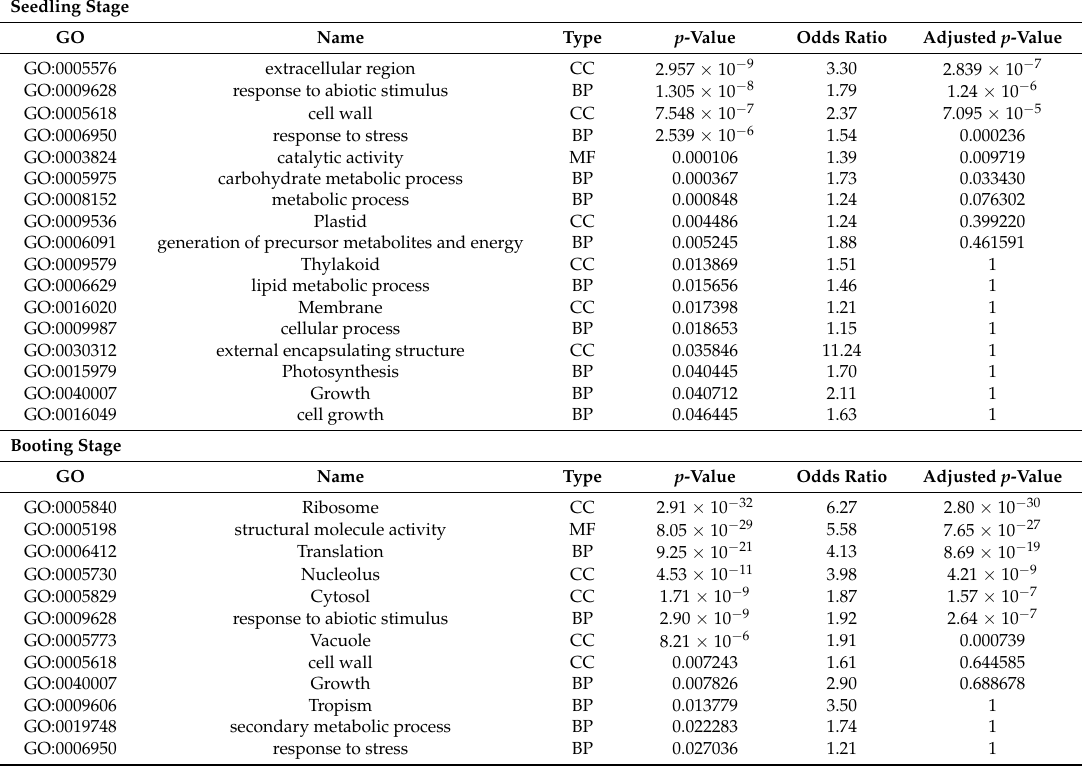
Table 3. Gene ontology (GO) enrichment analysis for differentially expressed genes.